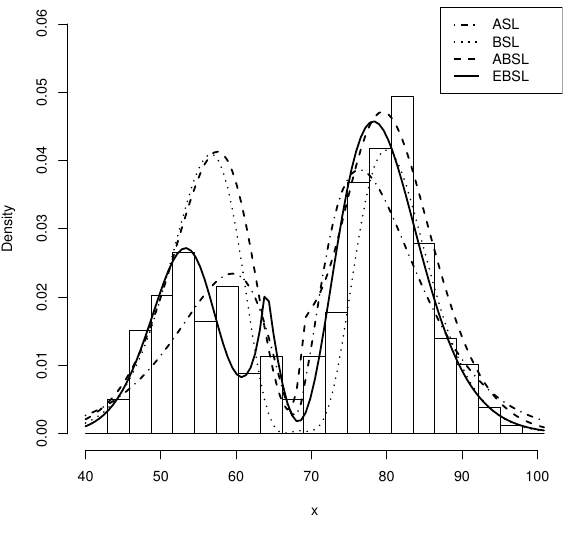
Figure 5. Old faithful geyser data: Density function of the fitted